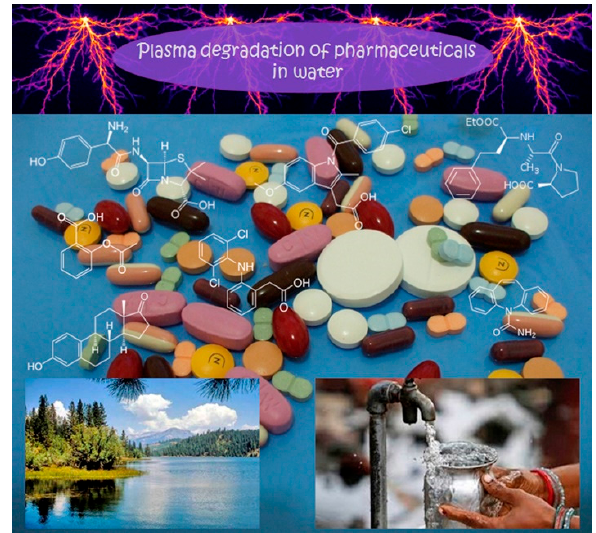
Figure 8. Application of NTAPP for the degradation of pharmaceutical compounds in water (reprinted with permission from [107], Copyright Elsevier (2015)).